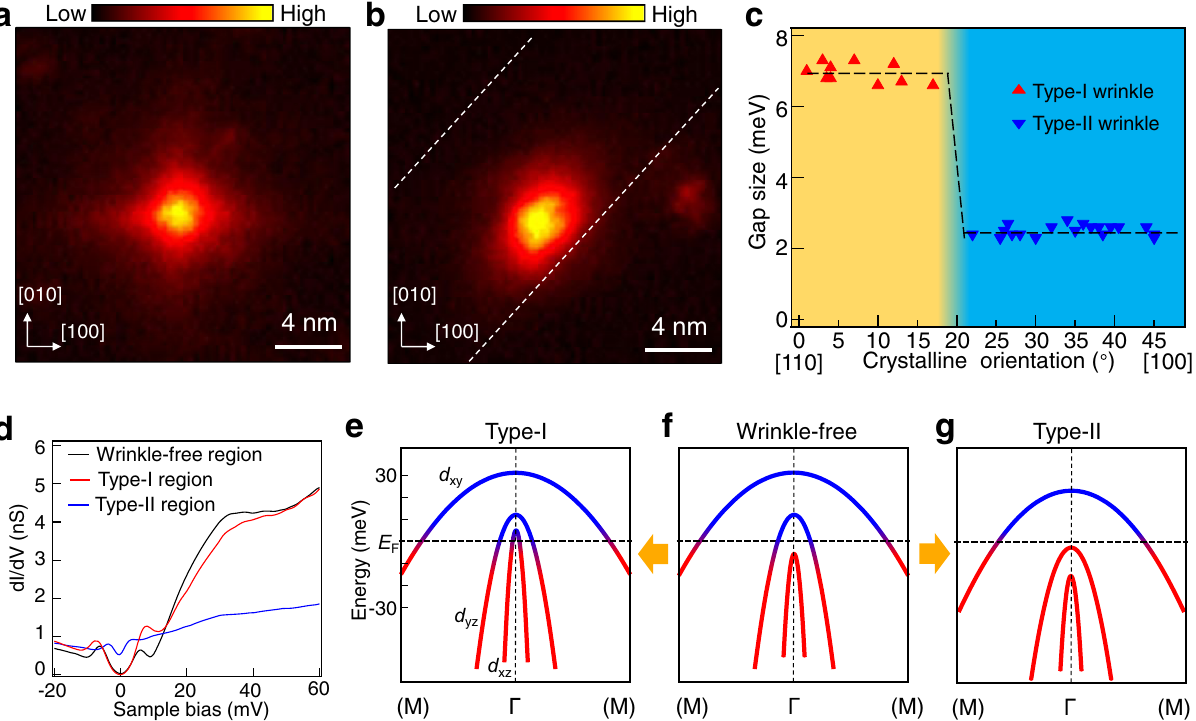
Fig. 4 Uniaxial strain-induced band shifting. a , b Zero-bias conductance map of vortices at wrinkle-free region and type-I wrinkle, respectively. The white dashed line in ( b ) indicate the wrinkle edge. Setpoint: V s = − 10 mV, I t = − 200 pA. c Statistics of orientations of the two types of wrinkles. The dashed line is a guide to eye. d The wide range of d I /d V spectra. Setpoint: V s = − 100 mV, I t = − 200 pA. The unit for d I /d V spectra is set to nS for the direct comparison of the LDOS at the three regions. e – g Sketches of the band structures of LiFeAs near the Γ point and the band shifting of two types of wrinkles. The energy scale is an estimation, not an accurate